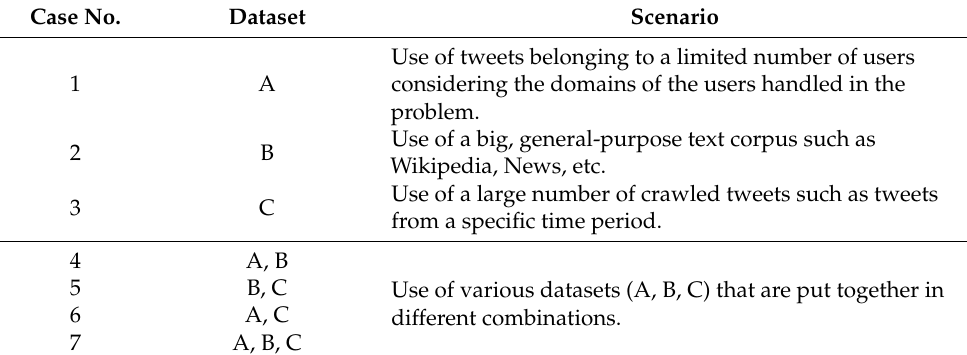
Table 5. Experimental setup